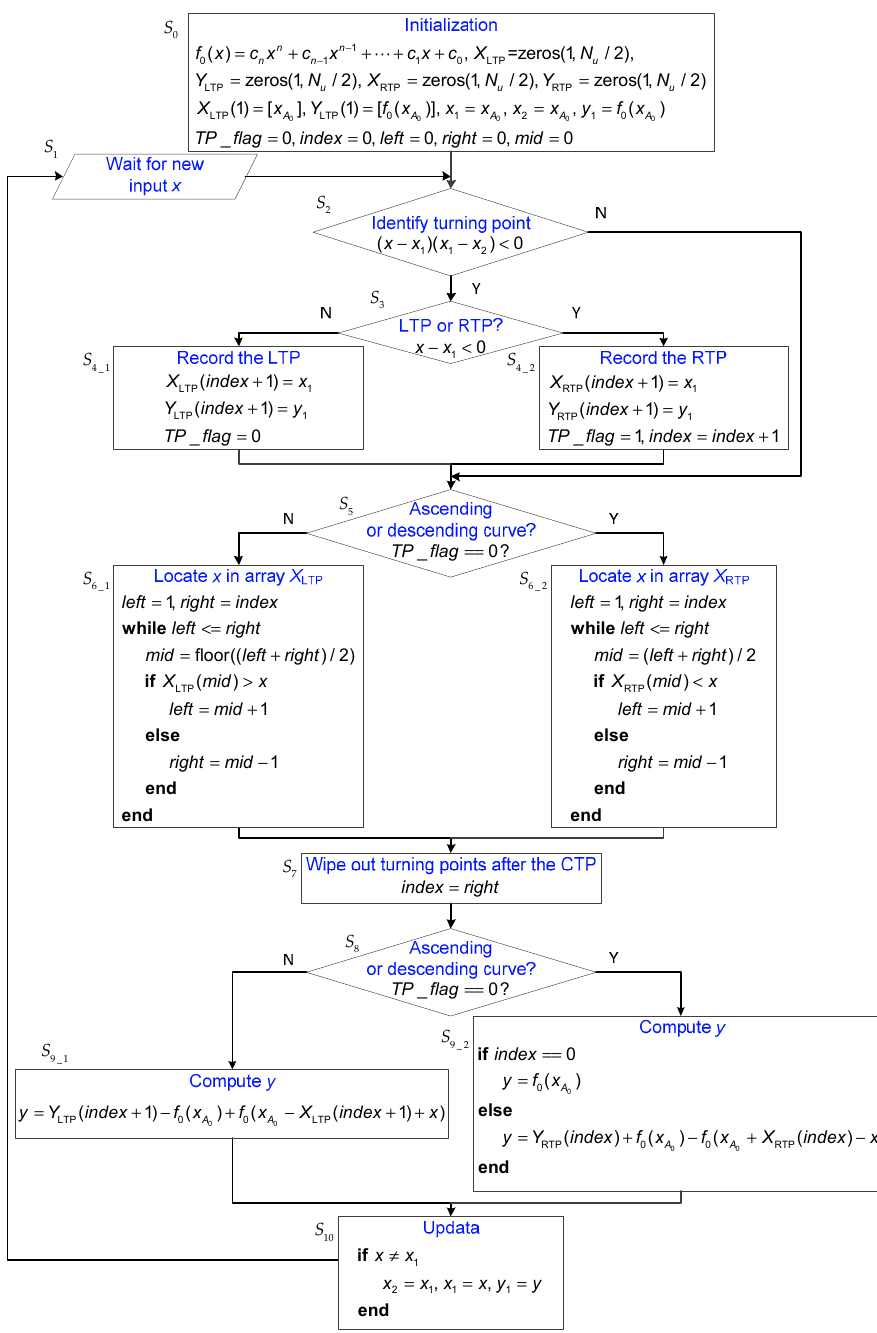
Figure 2. Flowchart of the trajectory construction method.